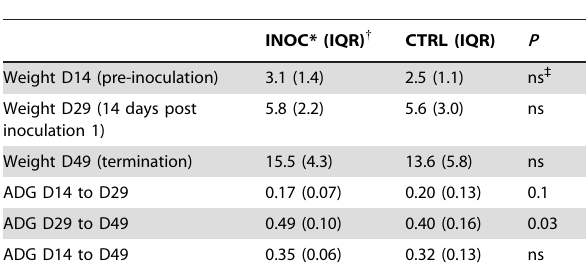
Table 2. Median body weight (kg) and average daily gain (ADG; kg/d) at selected time points following inoculation at day 14 and